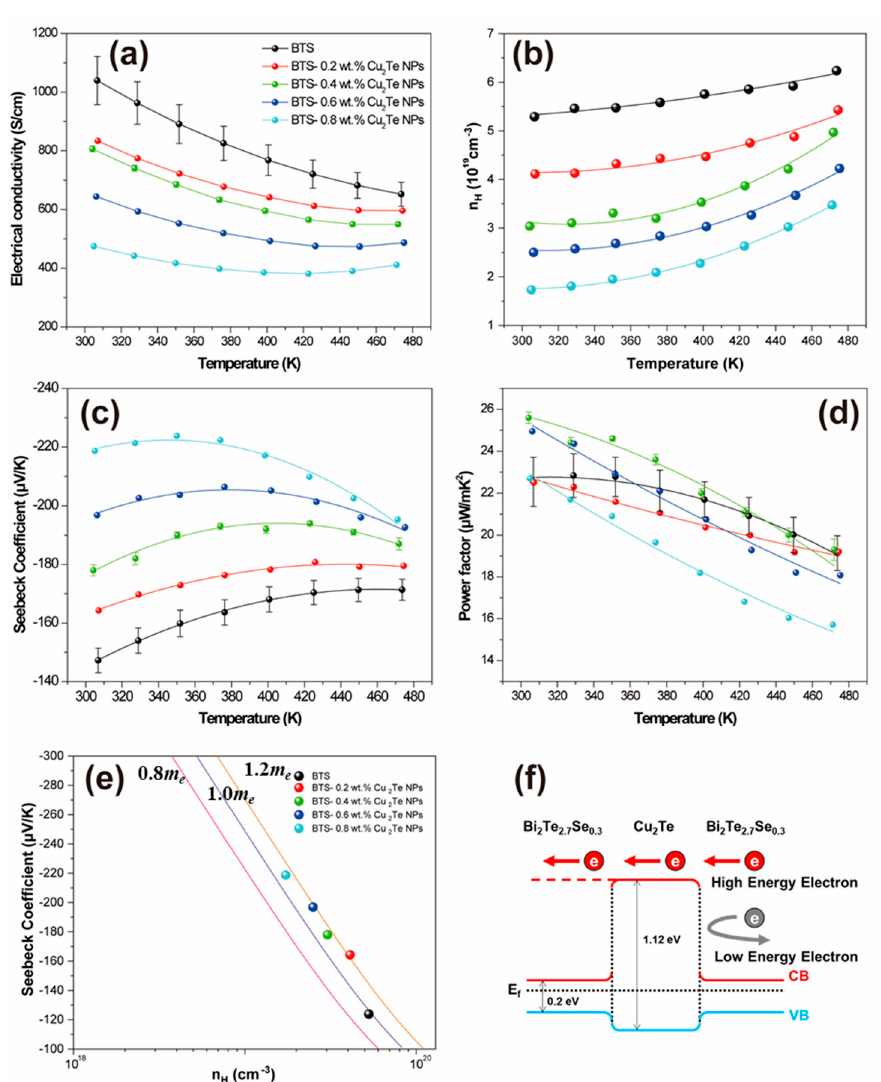
Figure 2. Electrical properties of BTS- x wt.% Cu 2 Te NPs ( x = 0, 0.2, 0.4, 0.6, and 0.8). ( a ) Electrical con- ductivities, ( b ) electron carrier concentrations obtained by Hall measurement, ( c ) Seebeck coefficients, ( d ) power factors, ( e ) Pisarenko’s plot, and ( f ) band diagram of BTS and Cu 2 Te NPs